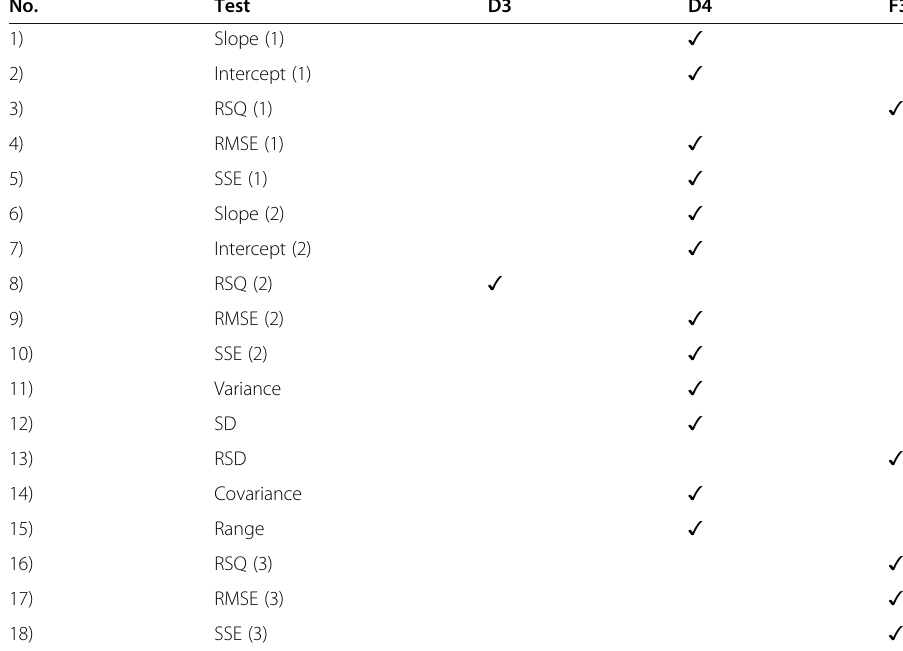
Table 1 The results of applying different tests to the different kinetic equations for determination of average k for reaction of MgO with charcoal in molar ratio 1:1 and at temperature 1723.15 K No.